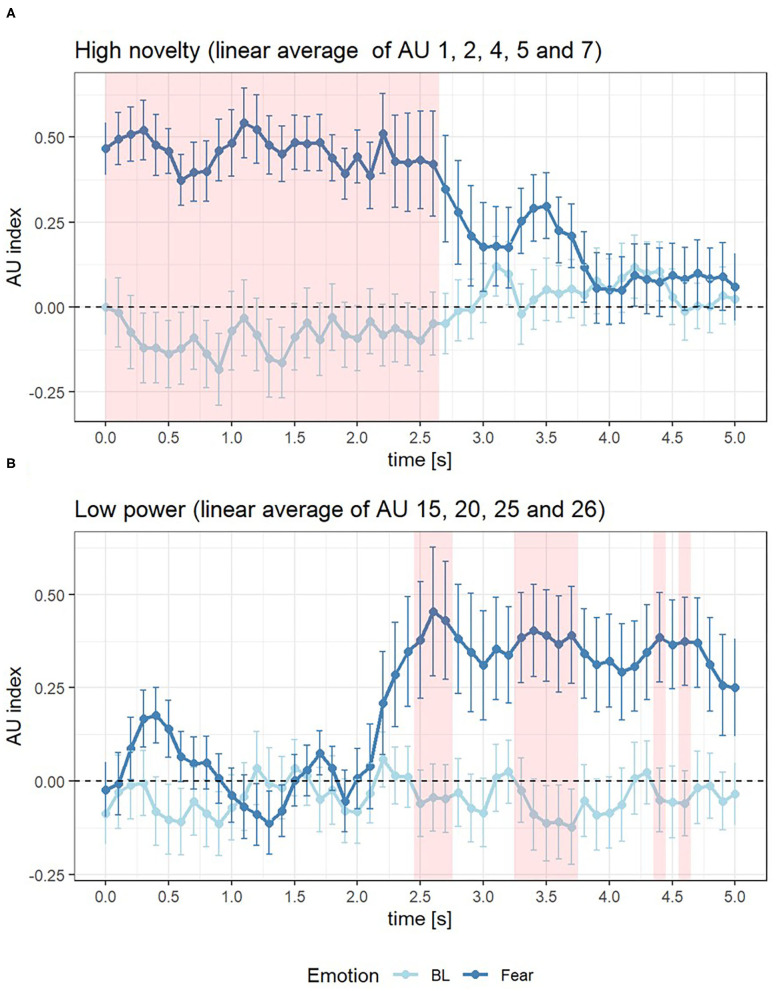
AU index of Fear (dark blue) and Baseline (BL, light blue) in 0–5 s after the onset of event for component of high novelty (A) and low power (B), where the red area represents the time interval when the AU index difference between Fear and BL >0.